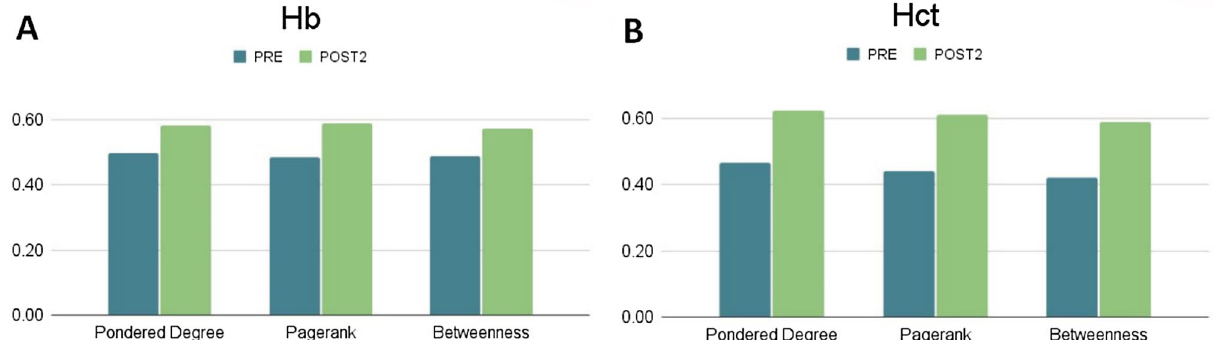
Figure 8. Node-based weighted Jaccard distances. ( A ) and ( B ) show the weighted Jaccard distances computed for the Hb and Hct variables, respectively, weighted by the pondered degree , pagerank and betweenness centrality